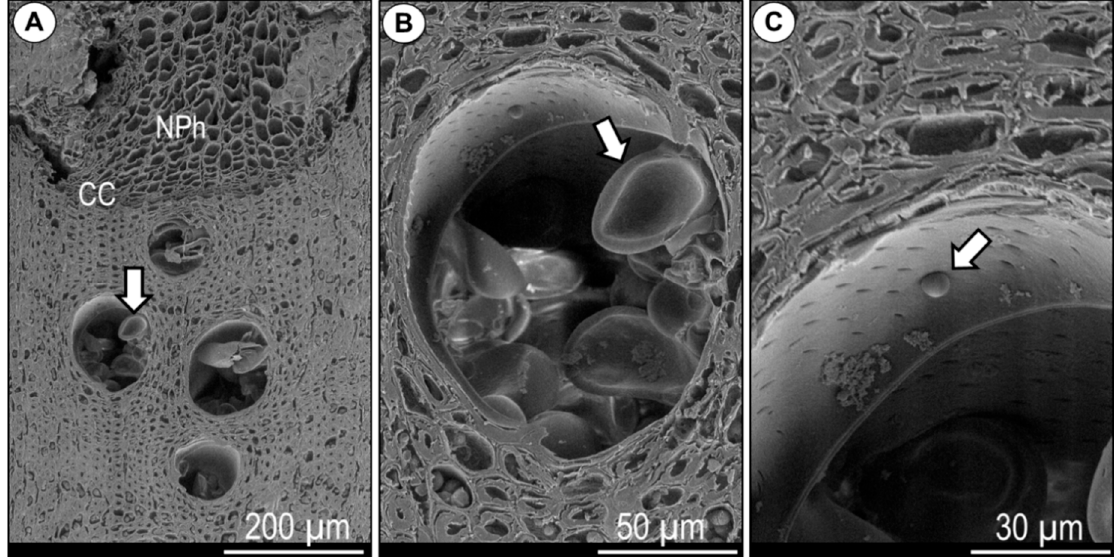
Figure 4. Cross-section of Q. ilex wood: ( A ) vessels with tyloses (arrow) in the last formed xylem increment below the cambium (CC) and non-collapsed phloem (NPh), and ( B ) detailed view of a vessel with tyloses from (A), and visible starch grains in parenchyma cells; ( C ) the beginning of tylosis formation with proliferation of a parenchyma cell into a vessel lumen through the vessel pit.